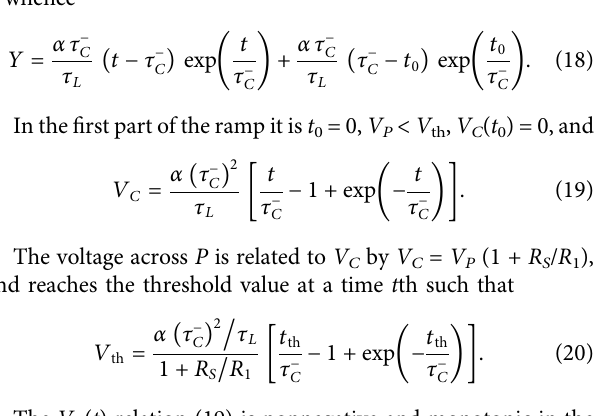
TABLE 1 | Microscopic parameters of Eqs. 6 , 7 , 9 , 10 . Apart from τ n , the parameter values are taken from